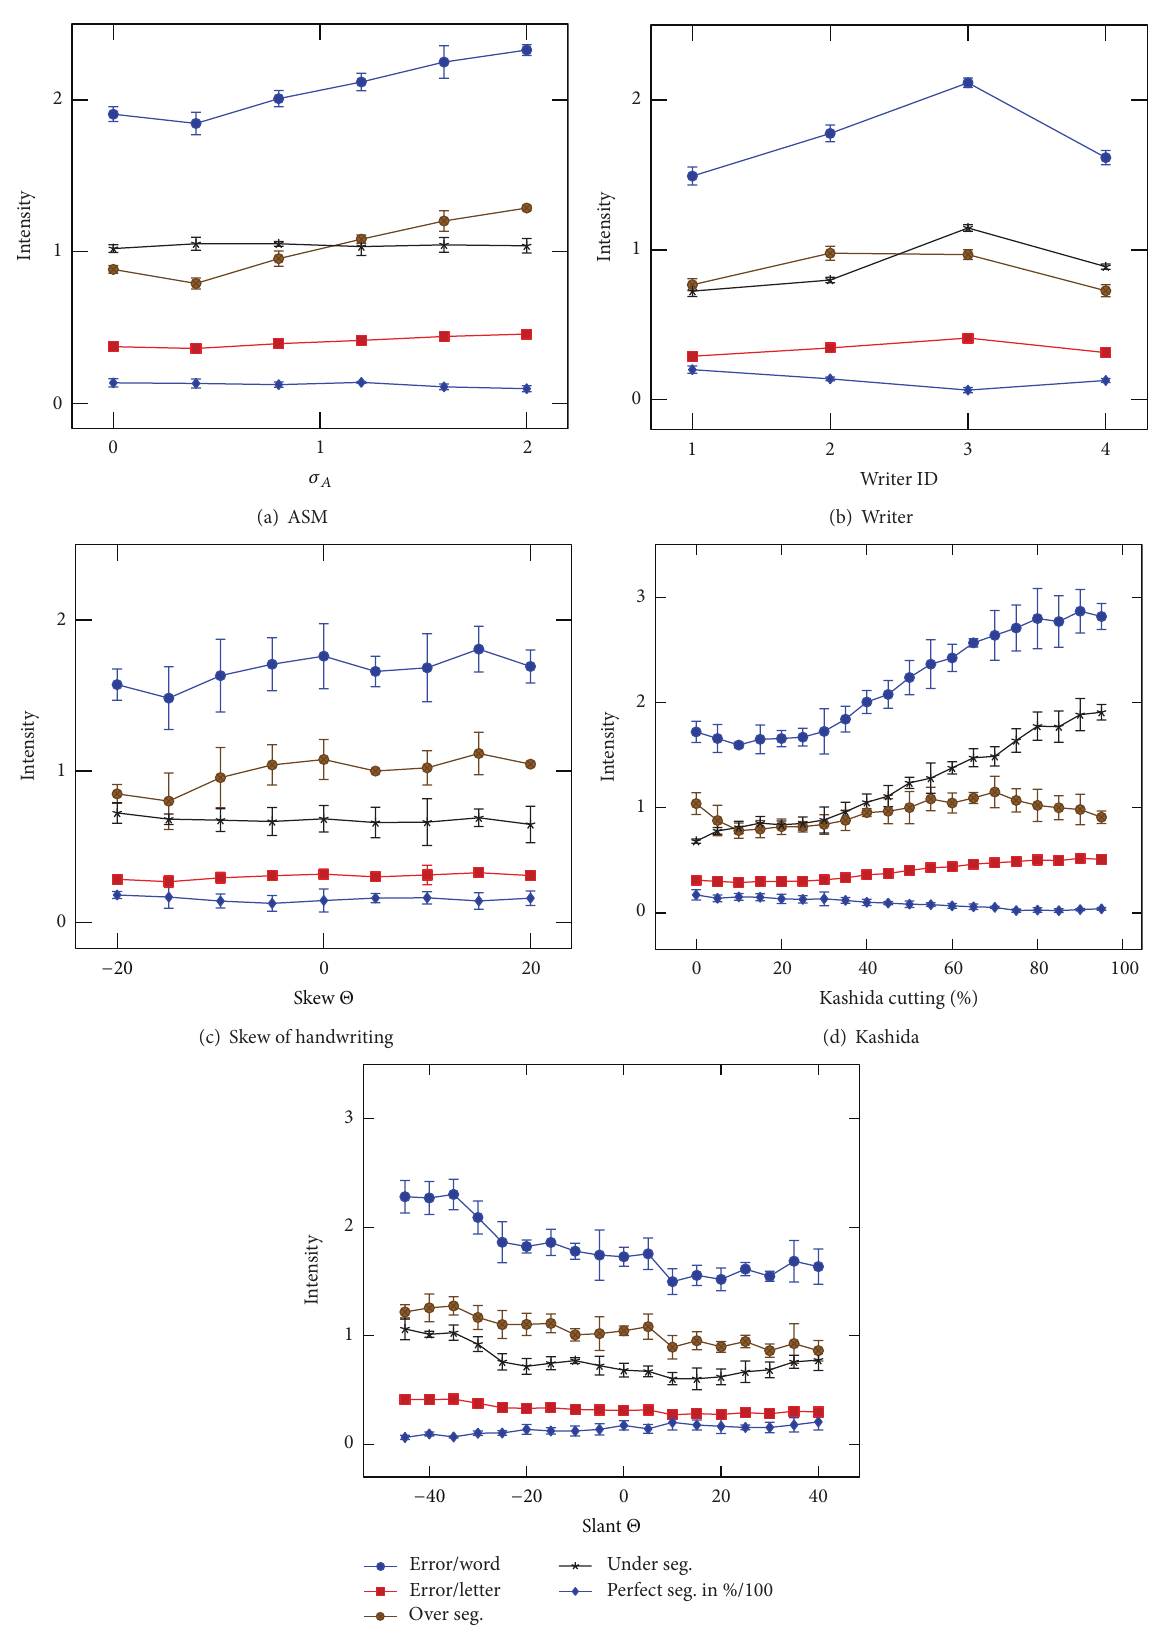
Figure 15: Experiments show the influence of different features on the average error of the word segmentation